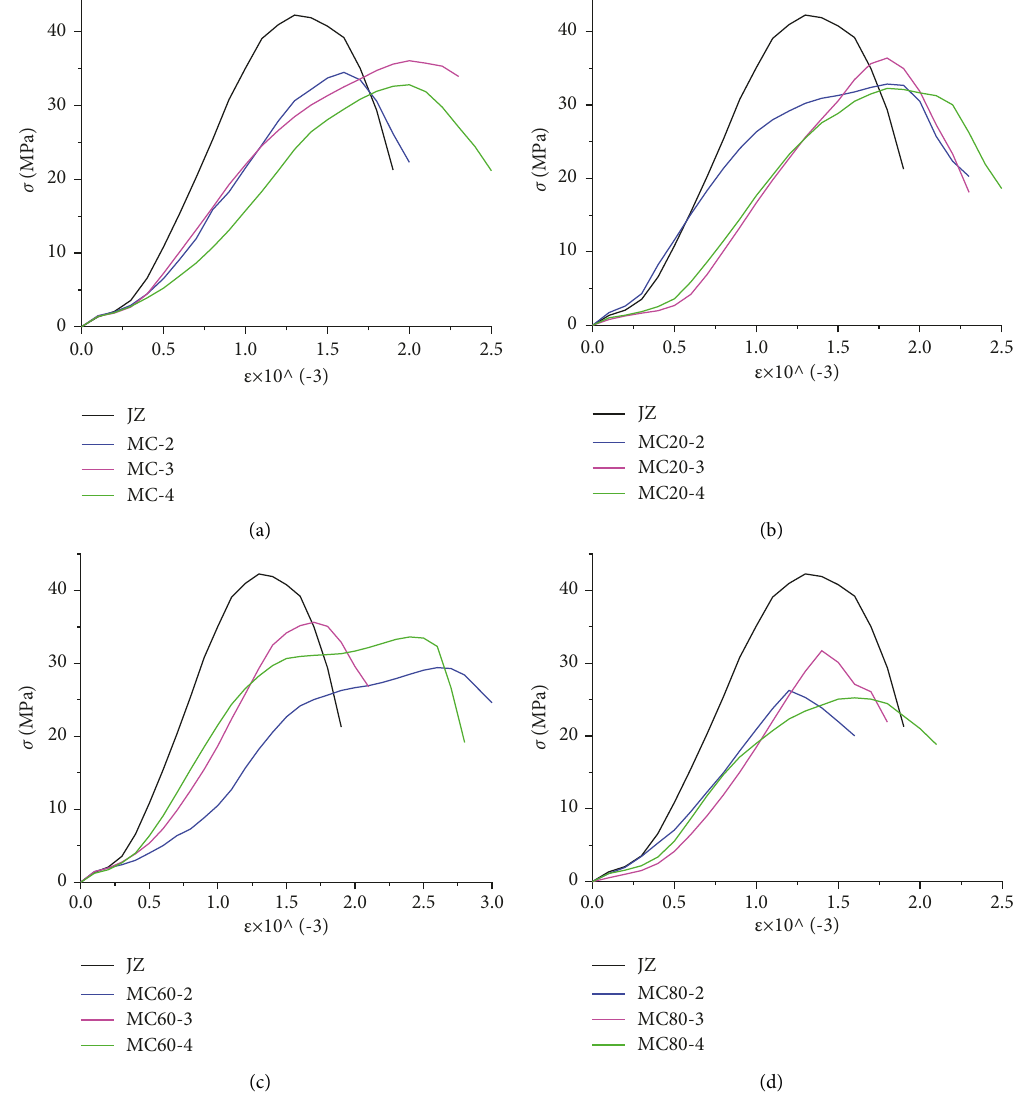
Figure 6: Stress-strain curves of different concrete groups. (a) The stress-strain curves of MC group. (b) The stress-strain curves of MC20 group. (c) The stress-strain curves of MC60 group. (d) The stress-strain curves of MC80